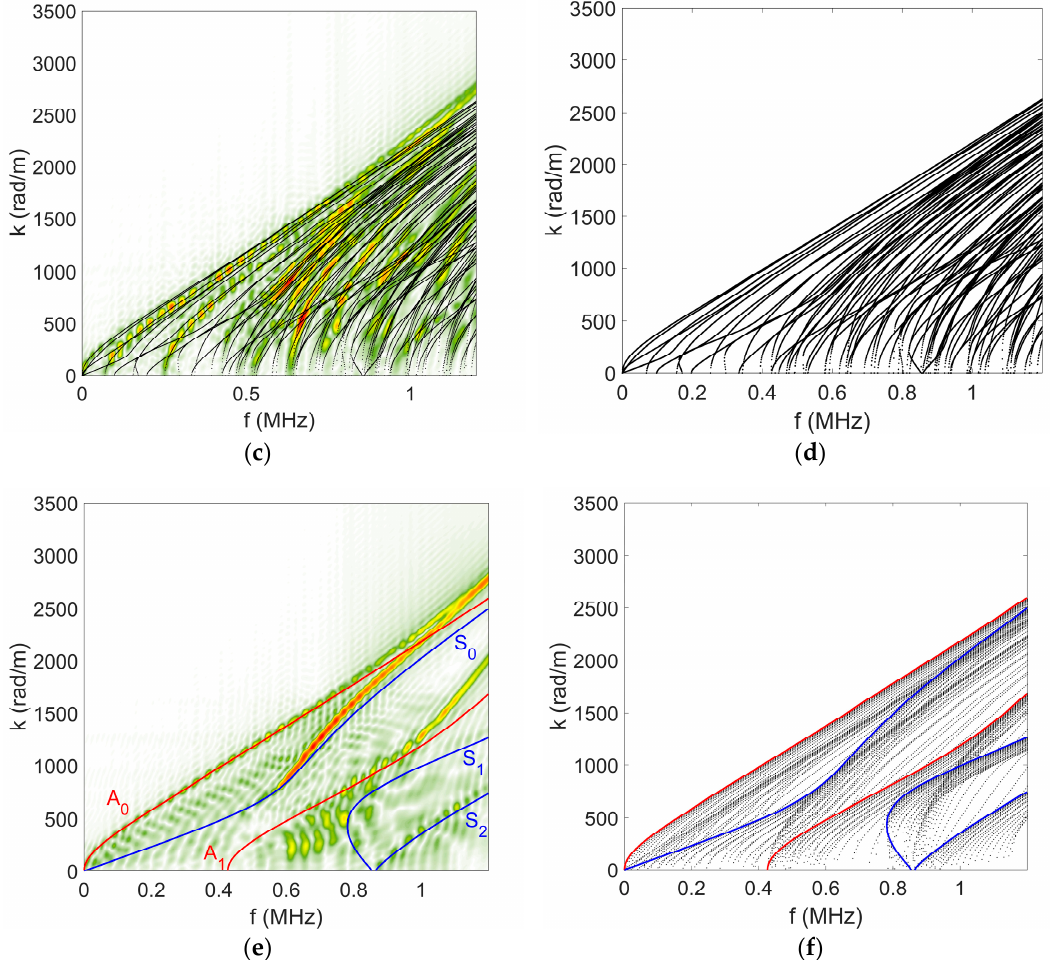
Figure 9. 2DFT (wavenumber k versus frequency f) of the numerical signals obtained applying a point force, whose temporal evolution is a chirp, on the surface of EPL3 ( a ), EPL16 ( c ), and EPL80 ( e ) geometries. Superimposed and on the side of each 2DFT, the theoretical modes are shown for bar ( b ), beam ( d ), and plate ( f ). These modes were calculated with a dedicated resolution algorithm using the semi-analytical discontinuous Galerkin method. In ( b ), the theoretical longitudinal, torsional and flexural modes of a beam have been superimposed to the semi-analytical curves in three different colors, while in ( f ), the analytical solutions of the Lamb modes of an infinite plate have been superimposed in red and blue.